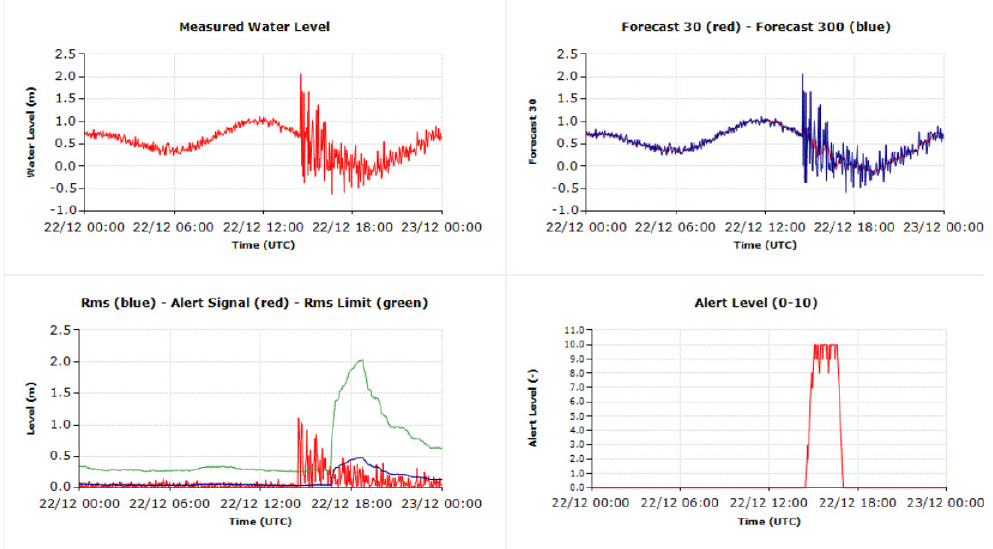
Figure 13. Results of the measurements and the calculated quantities from Marina Jambu, Java, Indonesia during the 2018 volcanic eruption event. The image is a screenshot of the published web data; it did not appear online during the event.